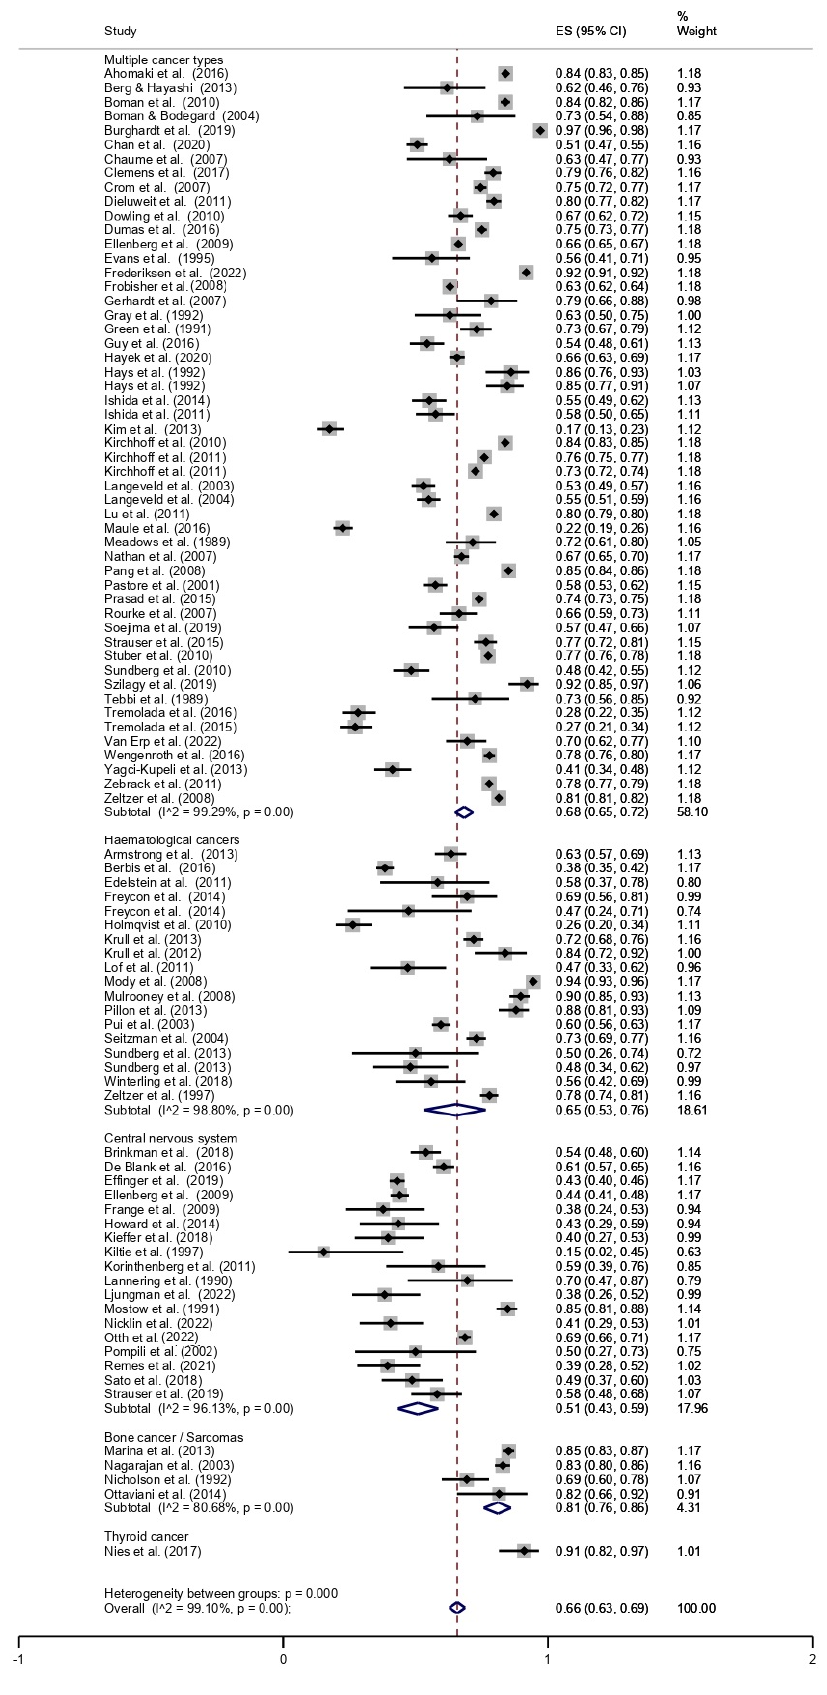
Figure 2. Forest plot stratified by cancer type [13–101].